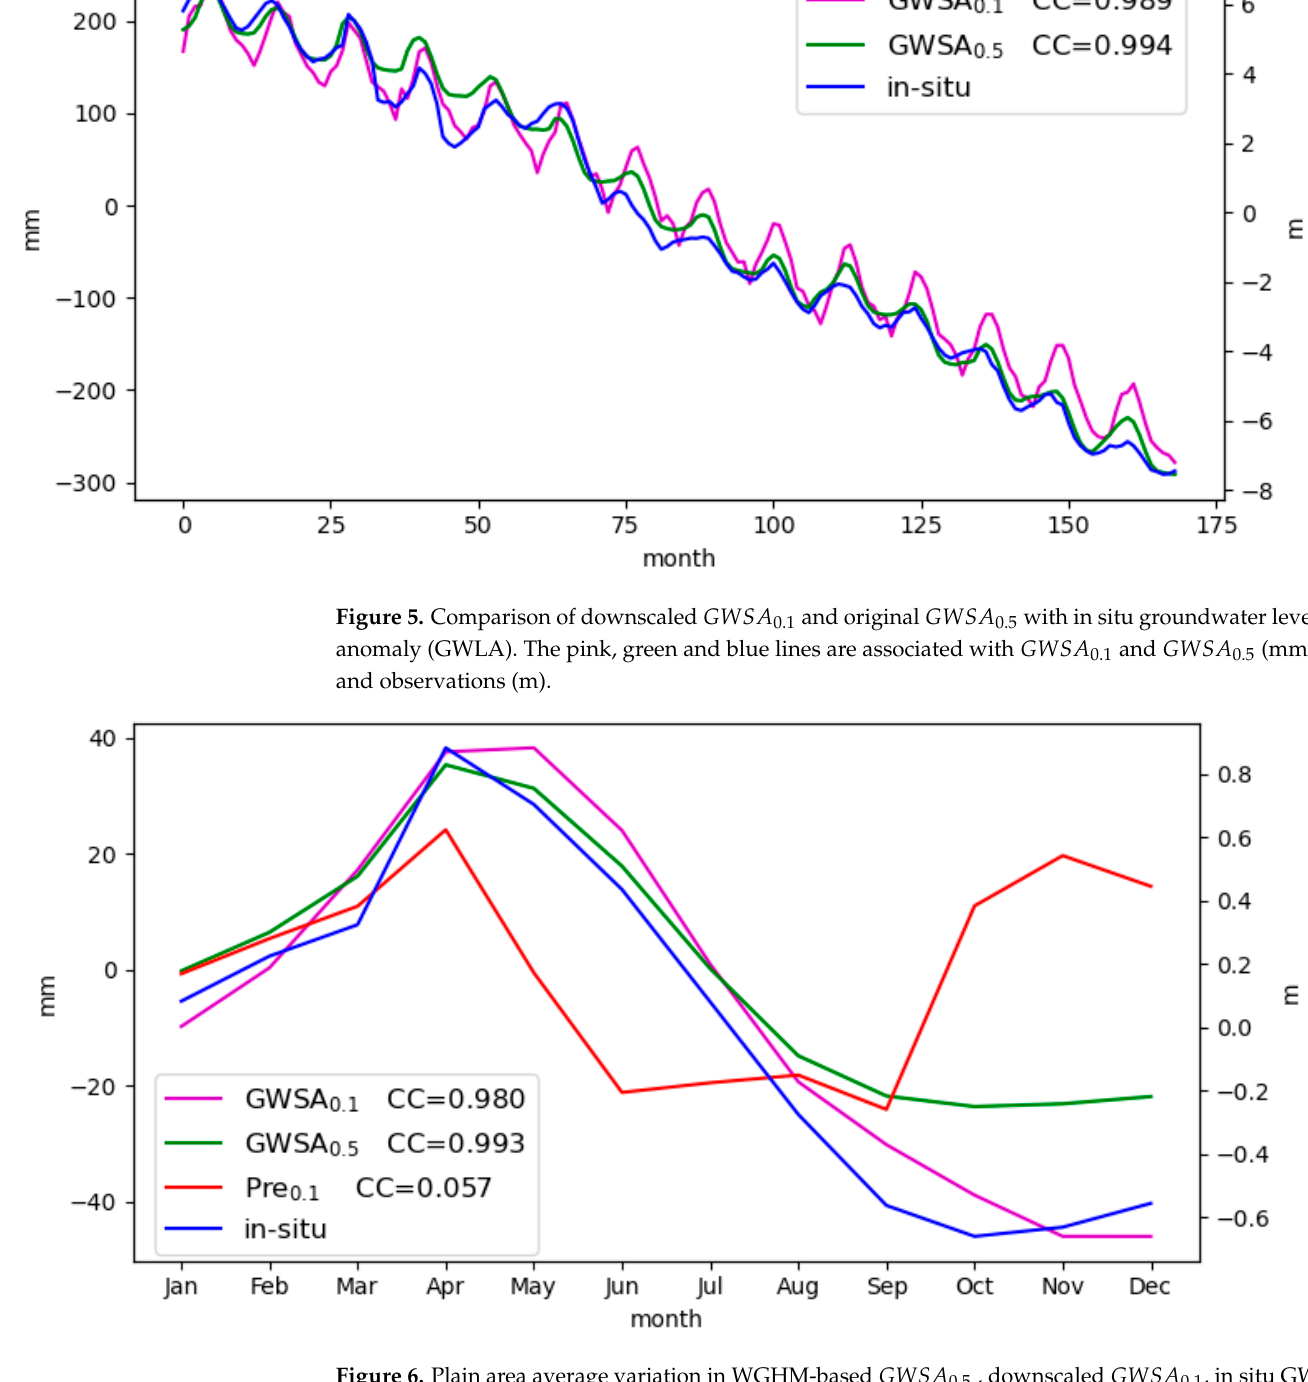
Figure 6. Plain area average variation in WGHM-based GWSA 0.5 , downscaled GWSA 0.1 , in situ GW observations, and precipitation anomaly ( Pre 0.1 ).